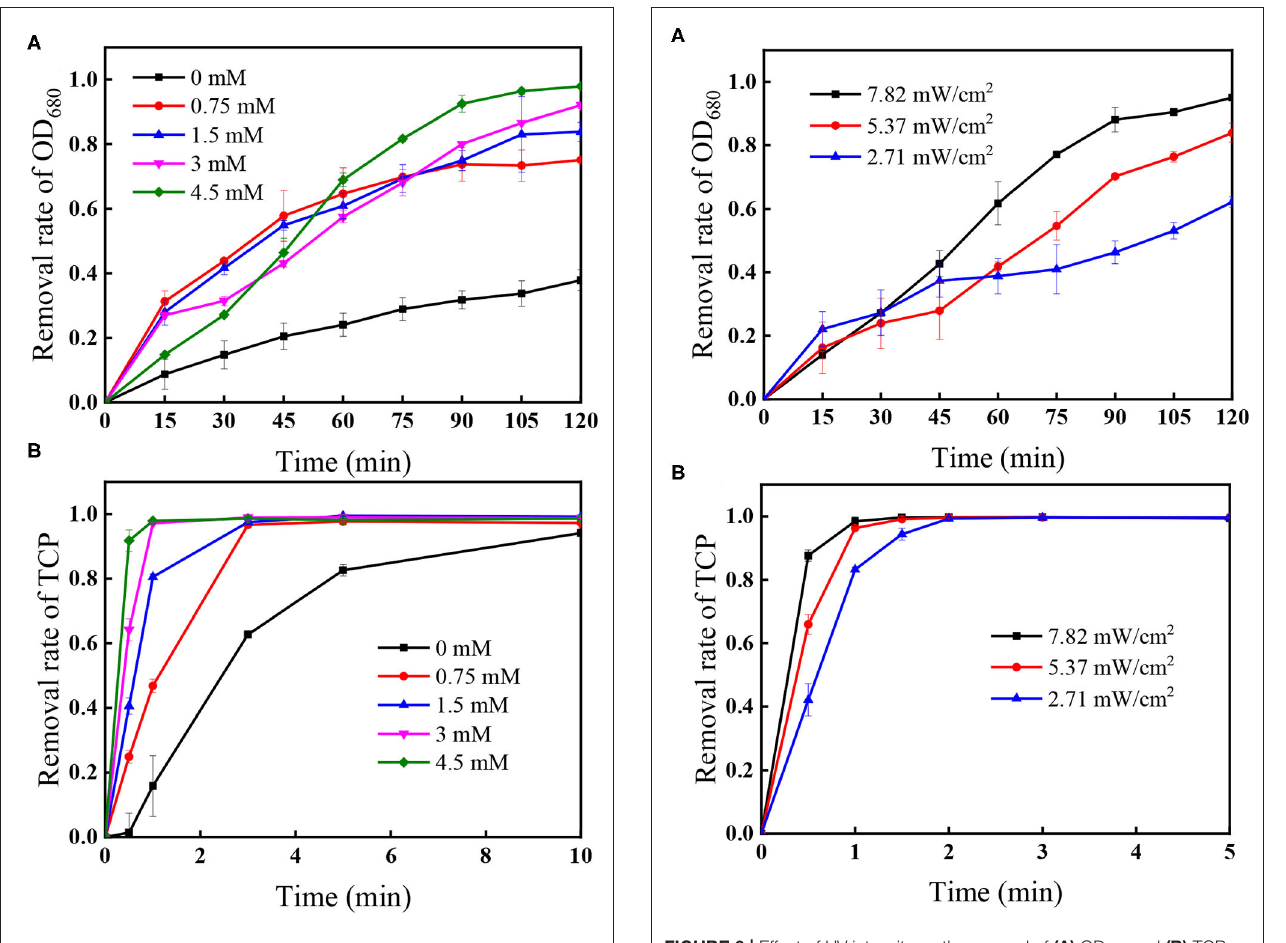
FIGURE 5 | Effect of PS dose on the removal of (A) OD 680 and (B) TCP. Conditions: initial algal cell density: (1.00 ± 0.05) × 10 6 cells/mL, initial TCP concentration: 20 µ M, initial pH: 7.6 ± 0.2, temperature: 25 ± 1 ◦ C, UV intensity: 7.82 mW/cm 2 . The error bars represent the standard deviations from duplicate tests.